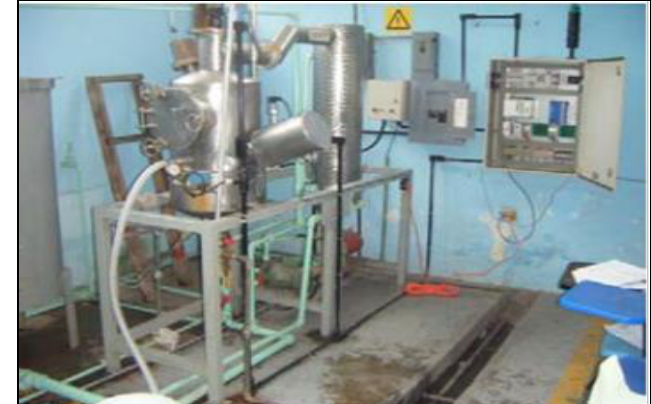
Figura 1: Cristalizador-Evaporador. Fuente: Los autores, (2018).